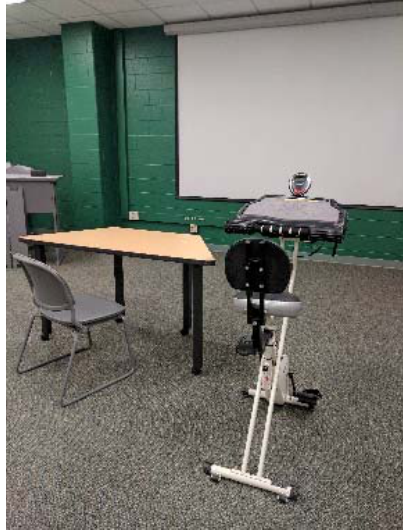
Figure 1. Traditional chair and desk compared to stationary cycle desk (FitDesk, FD Products, Kernersville, NC, USA) in the college lecture classroom. Kernersville, NC, USA) in the college lecture